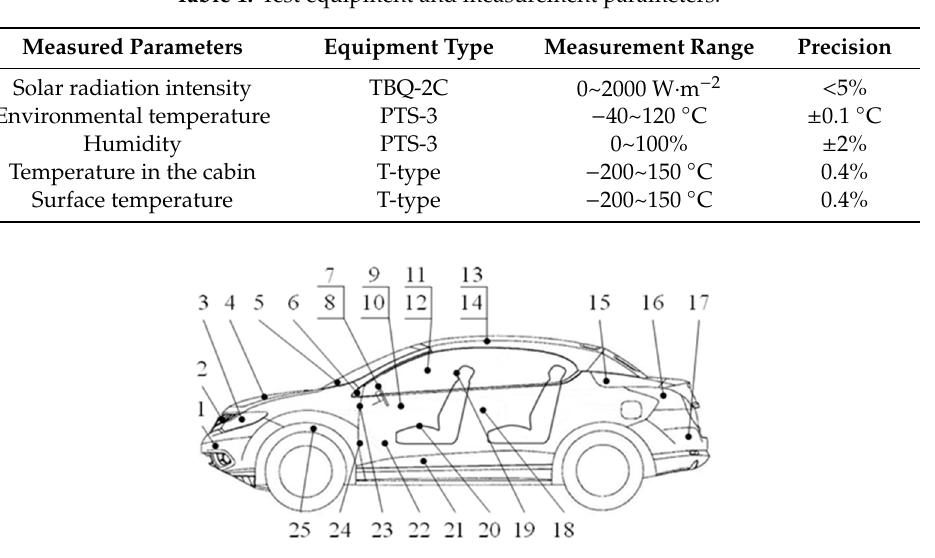
Table 1. Test equipment and measurement parameters.